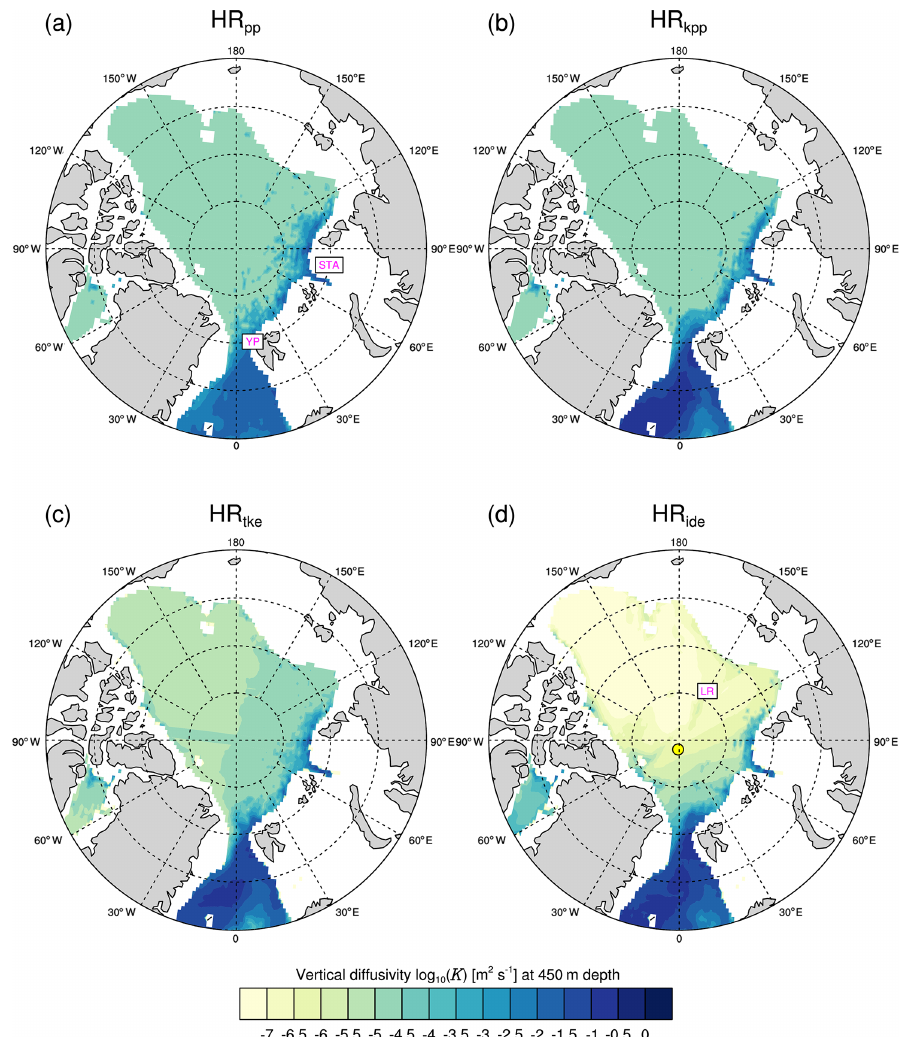
Figure 15. Time-averaged vertical diffusivity log 10 (K) (m 2 s − 1 ) at a depth of 450m in the Arctic Ocean and the Fram Strait simulated by MPI-ESM1.2 (a) HR pp , (b) HR kpp , (c) HR tke , and (d) HR ide . YP: Yermak Plateau, STA: St. Anna Trough, LR: Lomonosov Ridge. The yellow point marks the approximate position (89 ◦ N, 7 ◦ W) of the Barneo ice camp in the Amundsen Basin, where K on the O( 10 − 6 m 2 s − 1 ) was measured below the mixed layer (Fer,